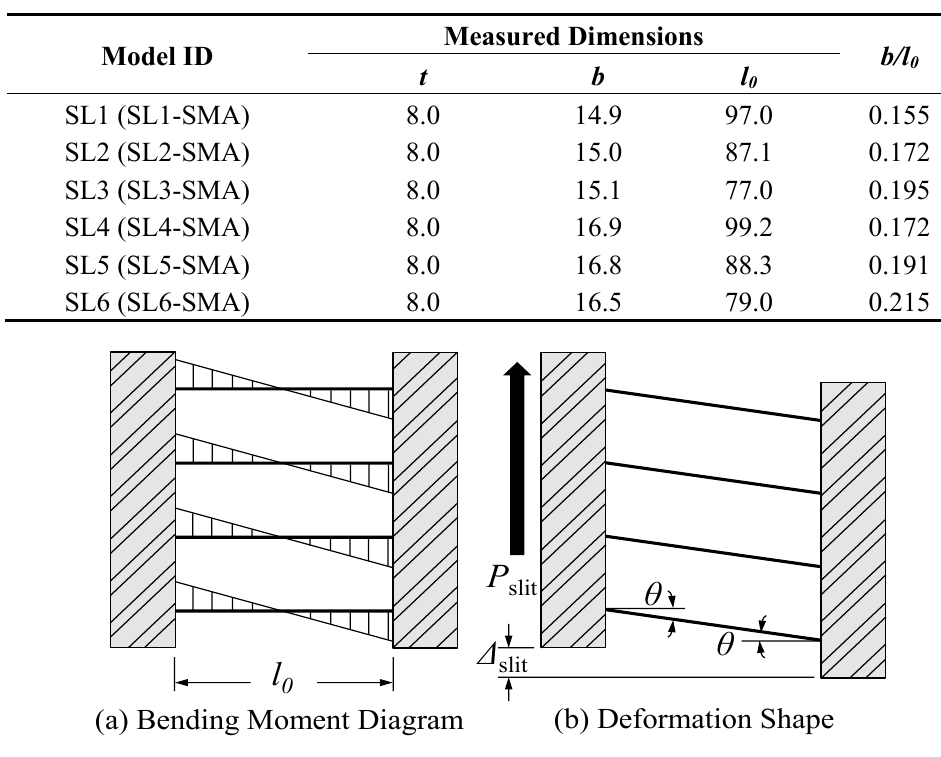
Figure 4. Response mechanism of slit damper models, ( a ): Bending Moment Diagram, ( b ): Deformation